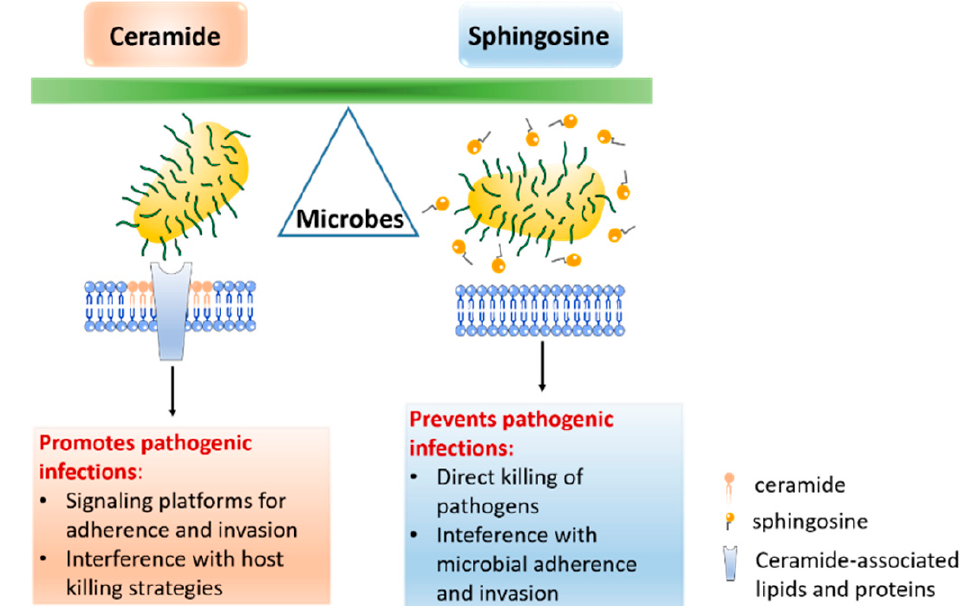
Figure 2. Model illustrating the different effects of ceramide and sphingosine on microbial infec- tions. While sphingosine prevents many bacterial, viral and fungal infections, ceramide often pro- motes pathogenic infections, by mediating adhesion and internalization or by interfering with the killing strategies of the host.